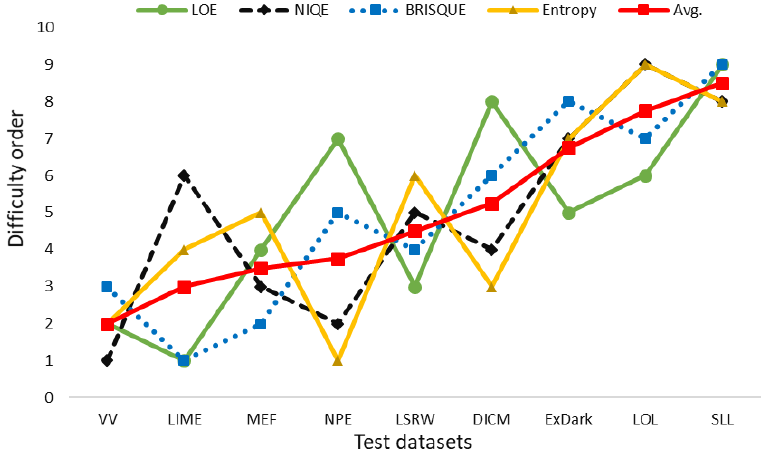
Figure 6. Each test dataset has been ranked based on its difficulty. Rank values range from 1 to 9. A lower rank indicates less difficulty, a higher rank indicates more